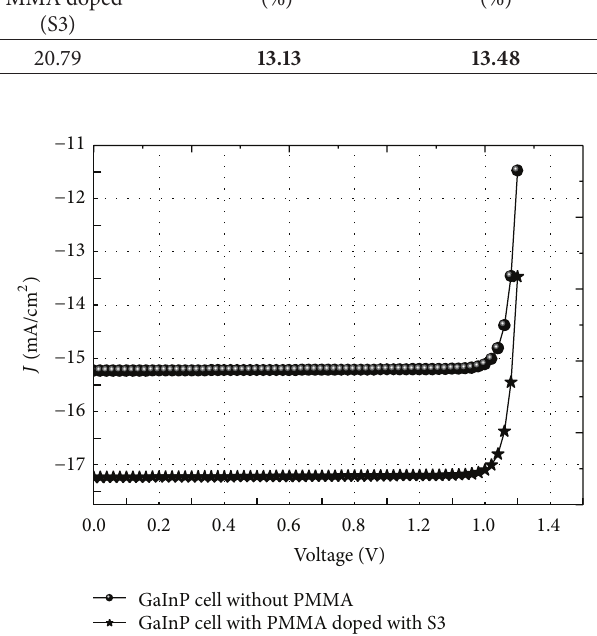
Figure 6: Simulation results of GaInP solar cell characteristics with and without LDS PMMA